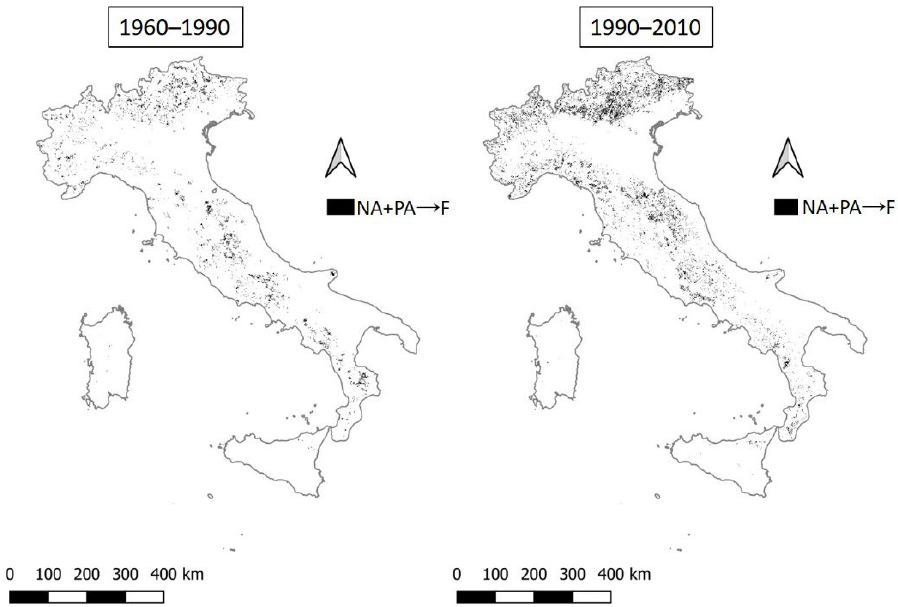
Figure 4. The transition from not affected or potentially affected land to fragile areas (NA+PA → F) by time interval.